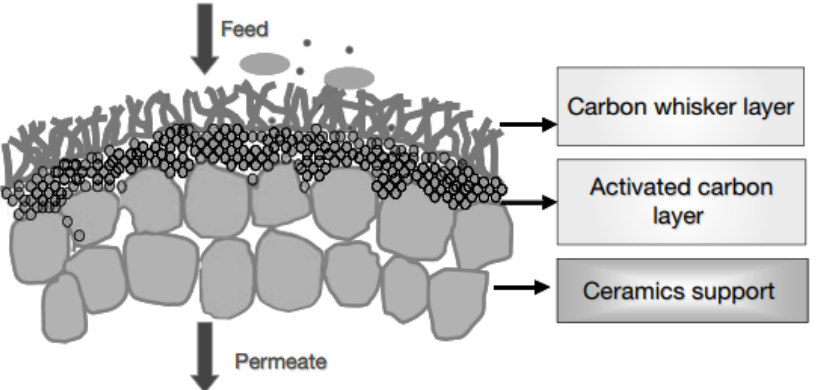
Figure 7. Scheme of a carbon fiber-modified activated carbon membrane. Diagram taken from [90].